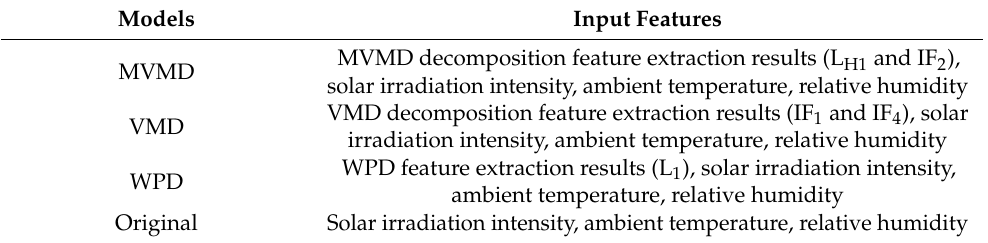
Table 4. The input features in each